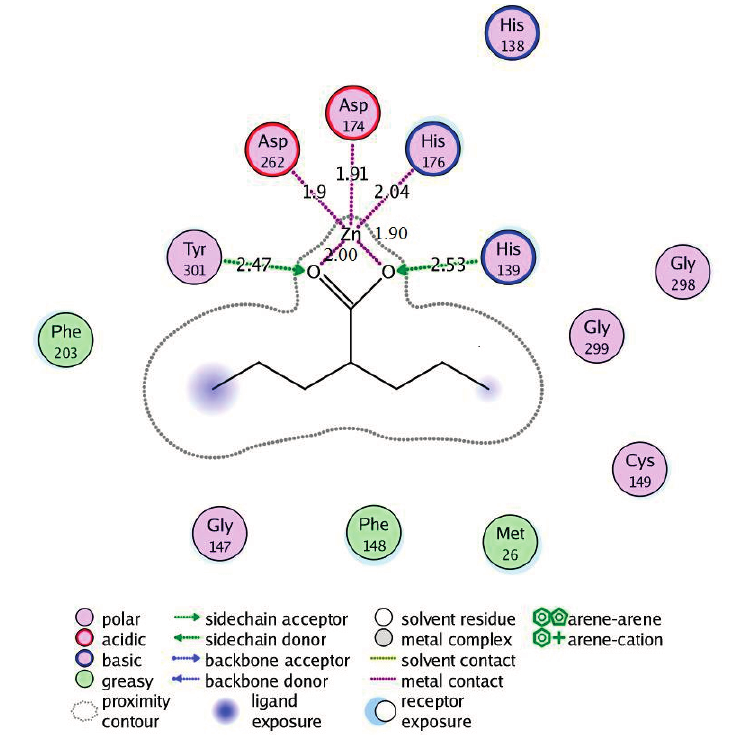
Figure 7. Valproic acid- Pf HDAC1 complex interactions.